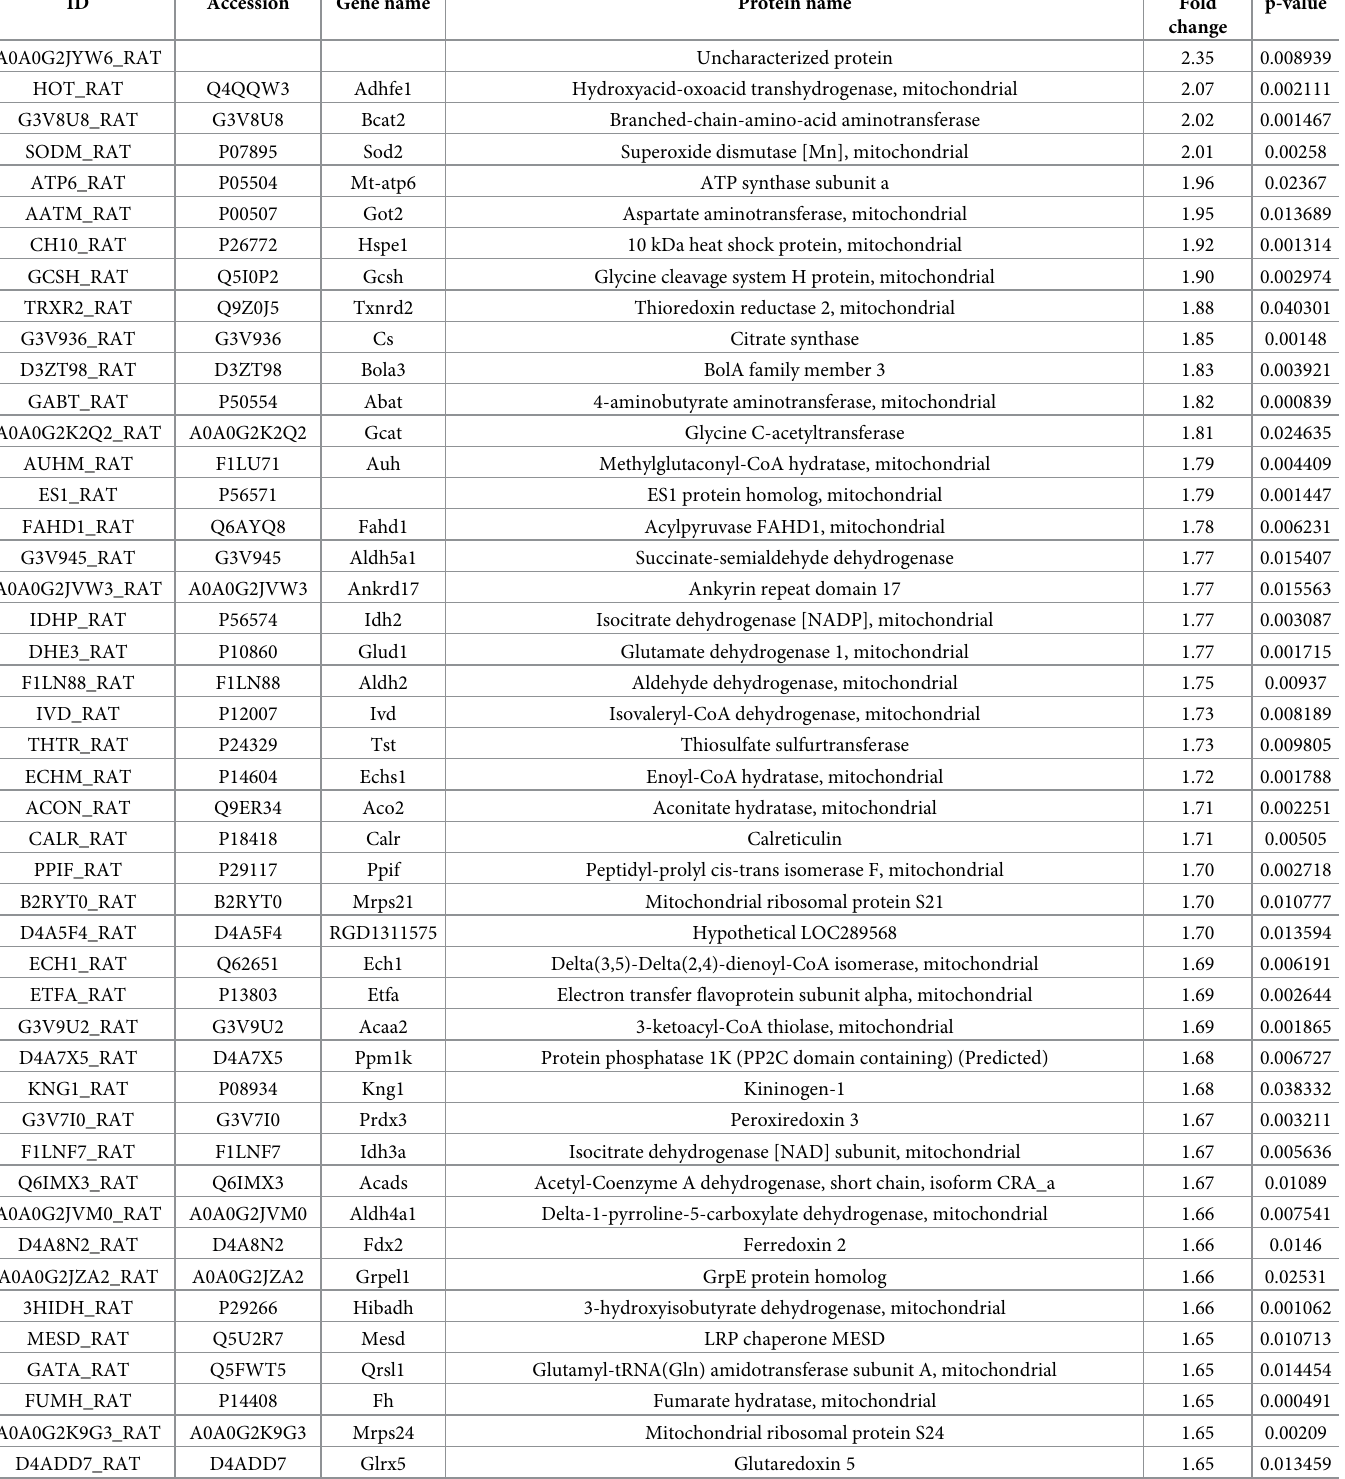
Table 1. The protein changes of mitochondria of hippocampus after 28 days of tail suspension in rats.